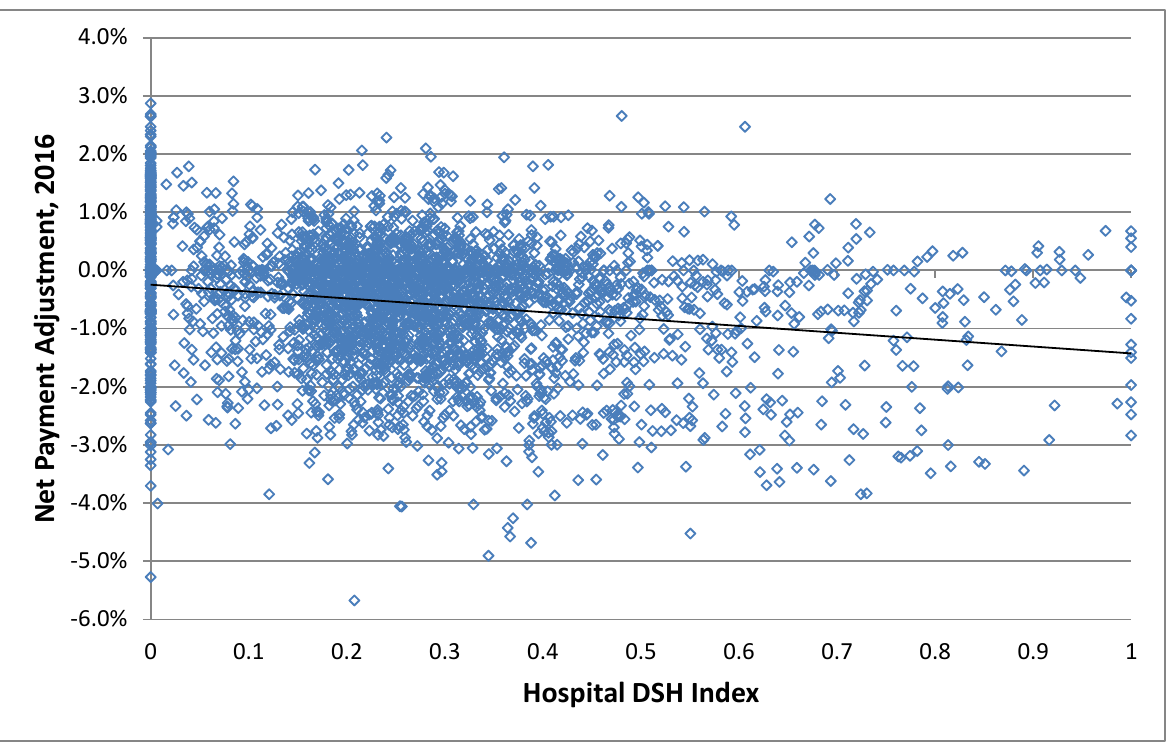
Figure S2.1: Net Financial Impacts of HRRP, HVBP, and HACRP in FY